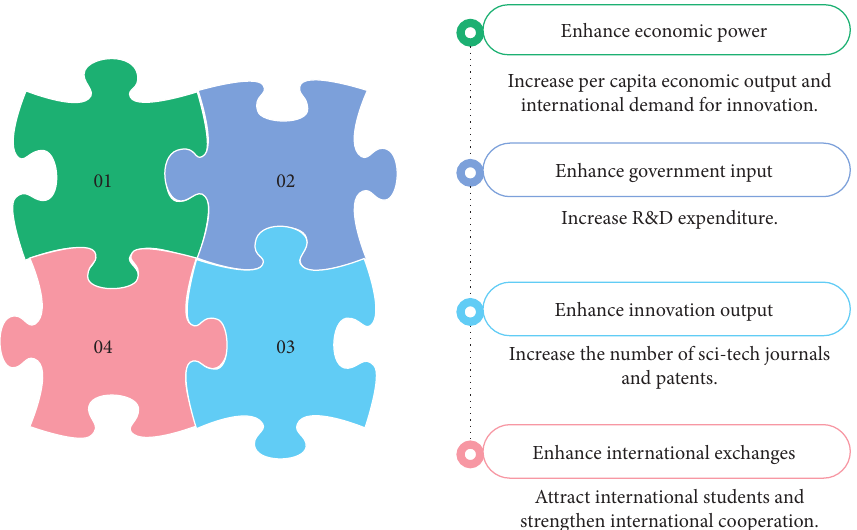
Figure 5: The circular promotion mechanism of policy